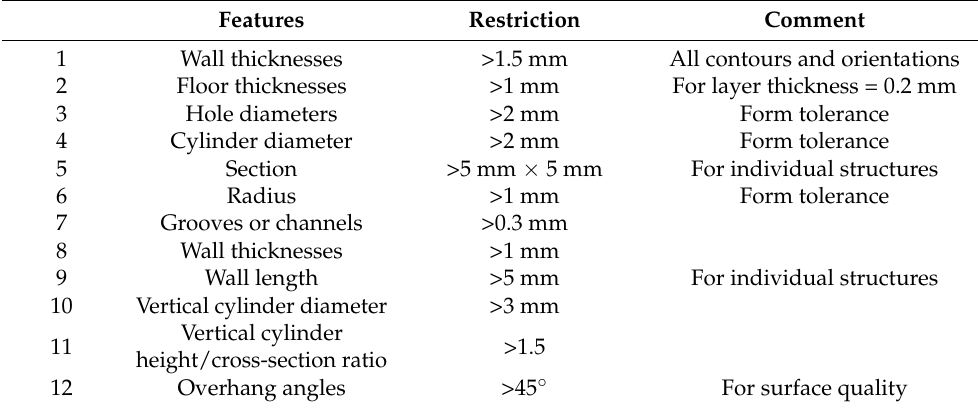
Table 1. Relevant FFF design guidelines for lattice structures, after Schäfer